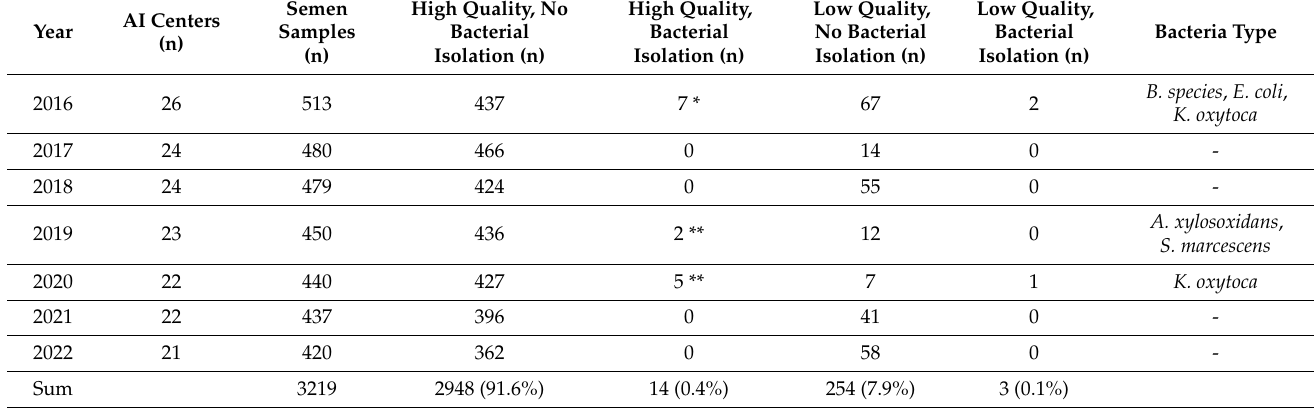
Table 1. Sperm quality and bacterial isolations in a seven-year quality monitoring program using 3219 random semen portions from 26 European AI centers (18 to 20 samples from each AI center). Low quality was defined as total motility < 70%; agglutination score >2 or >5%; defective sperm membranes > 90th percentil of the preceding